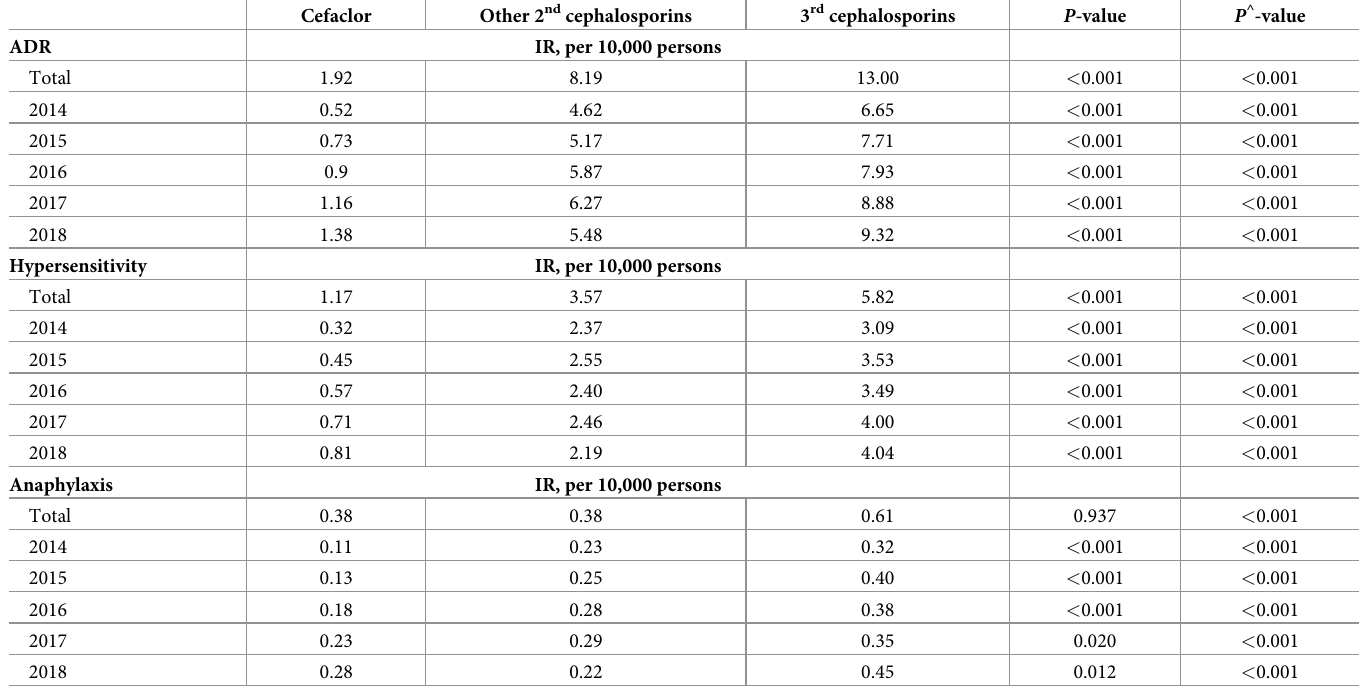
Table 3. Incidence rates of adverse drug reactions, hypersensitivity and anaphylaxis to cefaclor and other 2 nd and 3 rd